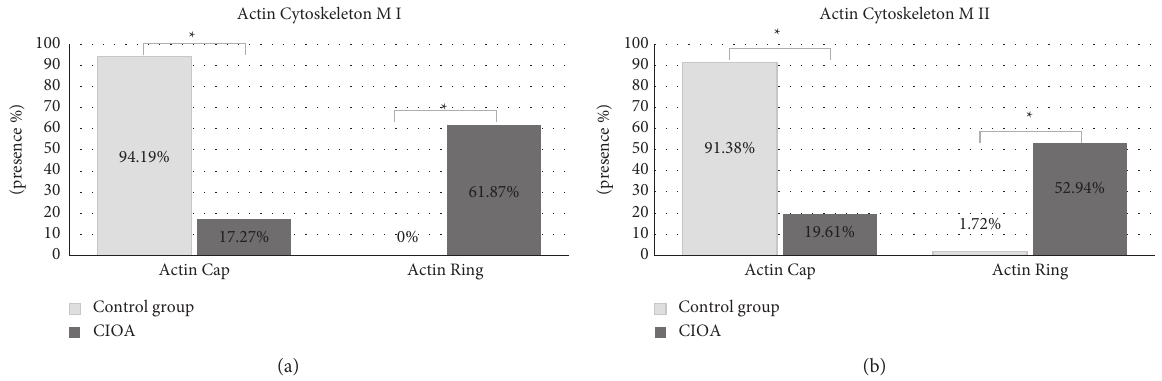
Figure 5: Actin cytoskeleton peculiarities. (a) Distribution of M I actin cap/ring, frequencies in %. Actin cap (grey) was present in 81 of 86 control oocytes and in 24 of 139 CIOA (black) oocytes. Actin rings were not present in any control oocytes and were present in 86 of 139 CIOA (black pattern) oocytes; Fisher–Freeman–Halton Exact Test, ∗ p < 0 . 001. (b) Distribution of M II actin cap/ring, frequencies in %. Actin cap (grey) was present in 106 of 116 control oocytes and in 10 of 51 CIOA (black) oocytes. Actin ring was present in 2 of 116 control oocytes (grey pattern) and in 27 of 51 CIOA (black pattern) oocytes; Fisher–Freeman–Halton Exact Test, ∗ p < 0 . 001.